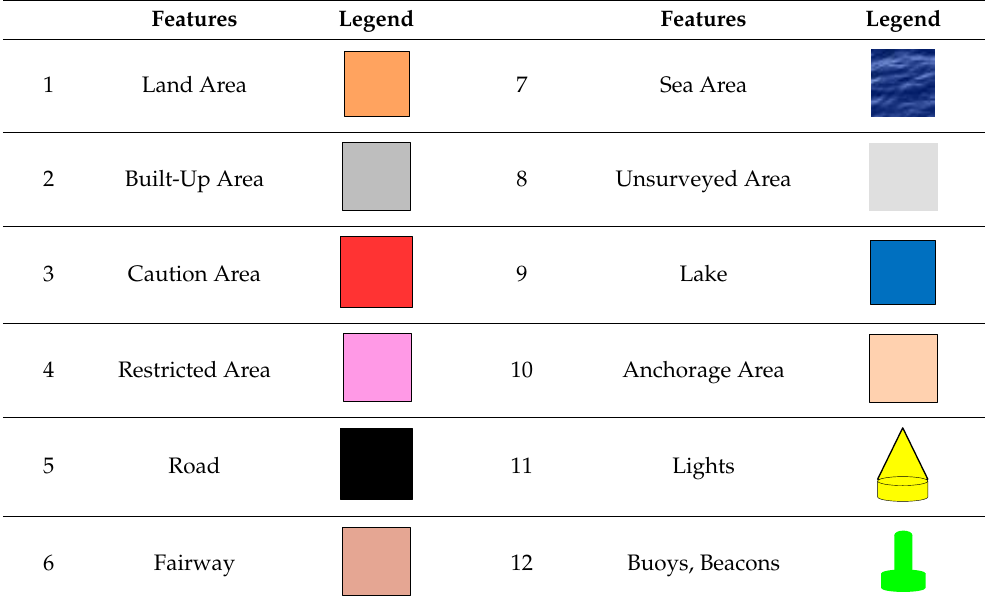
Table 4. ENC features legend.